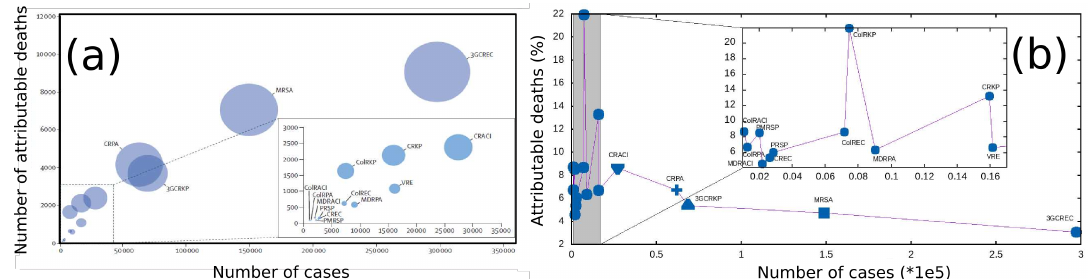
Figure 1. Infections with antibiotic-resistant bacteria, EU and European Economic Area, 2015. ( a ) The diameter of bubbles represents the number of disability-adjusted life-years [2]. ( b ) Each blue point represents antibiotic-resistant bacteria in EU and European Economic Area in 2015. Incidence cases are reported on the x -axis, the relative percentage of attributable deaths is reported on the y -axis. Bacteria are the same as in ( a ). ColRACI = colistin-resistant Acinetobacter spp. CRACI = carbapenem-resistant Acinetobacter spp. MDRACI = multidrug-resistant Acinetobacter spp. VRE = vancomycin-resistant Enterococcus faecalis and Enterococcus faecium . ColREC = colistin-resistant Escherichia coli . CREC = carbapenem-resistant E. coli . 3GCREC = third-generation cephalosporin-resistant E. coli . ColRKP = colistin-resistant Klebsiella pneumoniae . CRKP = carbapenem-resistant K pneumoniae . 3GCRKP = third-generation cephalosporin-resistant K pneumoniae . ColRPA = colistin-resistant Pseudomonas aeruginosa . CRPA = carbapenem-resistant P aeruginosa . MDRPA = multidrug-resistant P aeruginosa . MRSA = meticillin-resistant Staphylococcus aureus . PRSP = penicillin-resistant Streptococcus pneumoniae . PMRSP = penicillin-resistant and macrolide-resistant S pneumoniae Reprinted with permission from